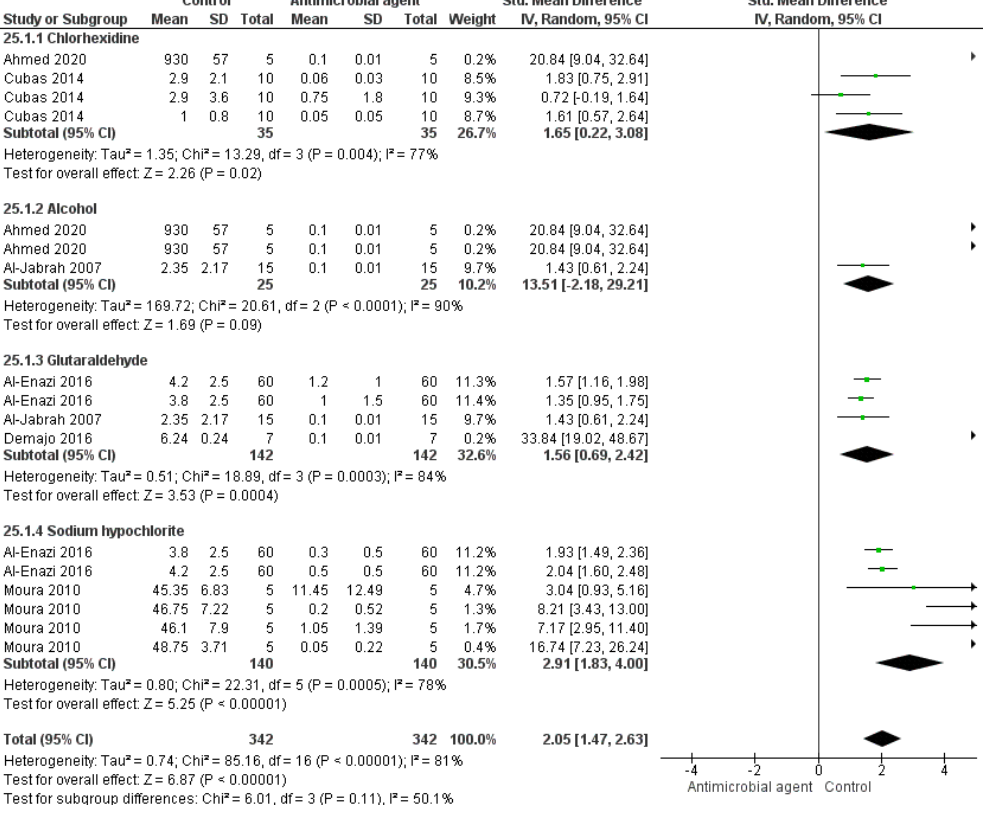
Figure 2. Forest plot of the analysis of CFU/mL count in alginate after disinfection.